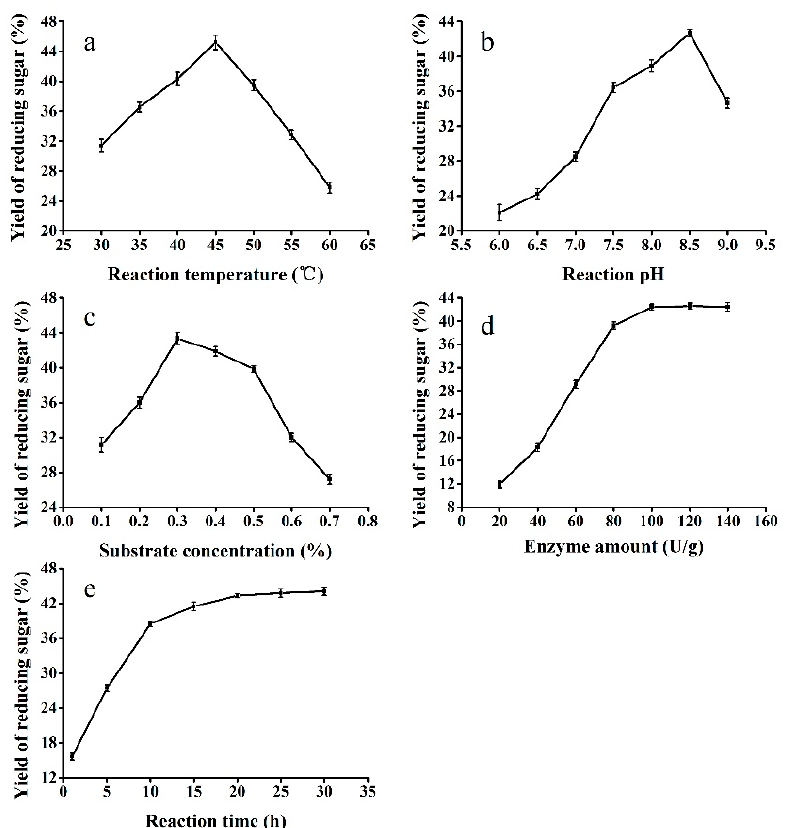
Figure 2. Effects of enzymolysis condition on reducing sugar yield. Figure 2. E ff ects of enzymolysis condition on reducing sugar